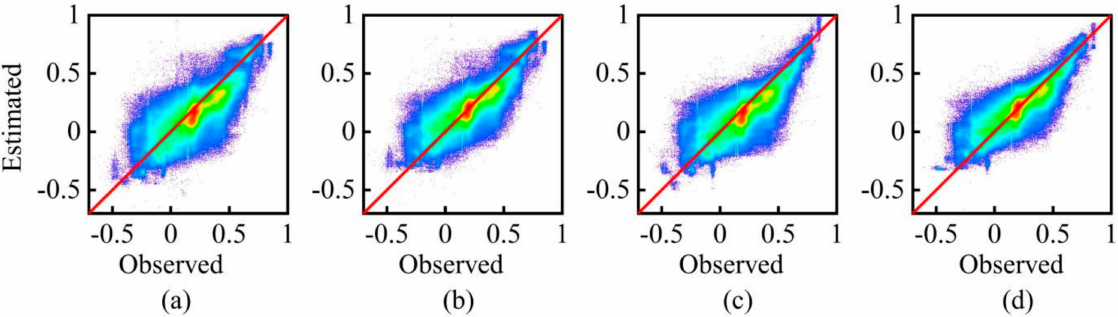
Figure 10. Scatter plots of NDVI and Landsat NDVI observations on 12 December 2004 estimated using various techniques: ( a ) FSDAF, ( b ) bias-corrected FSDAF, ( c ) STARFM, and ( d ) bias-corrected STARFM (the red line is the 1:1